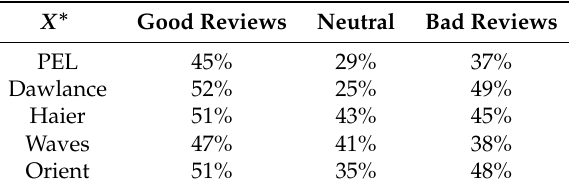
Table 1. Companies and their